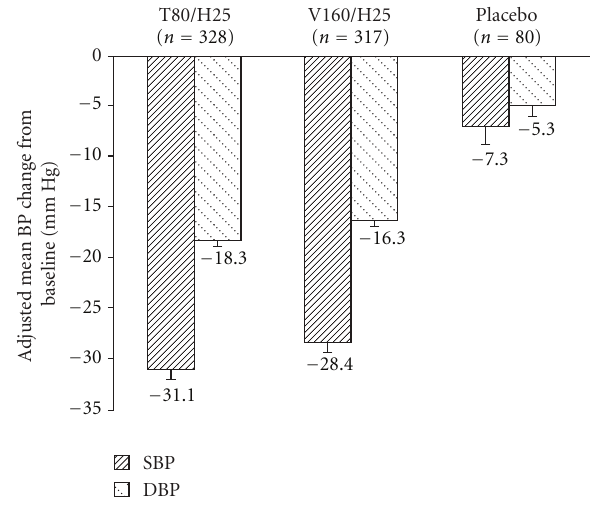
T80/H25 versus V160/H25: P = 0 . 0265 for SBP and P = 0 . 0041 for DBP. T80/H25 versus placebo: P < 0 . 001 for both SBP and DBP. Figure 1: Change from baseline in SBP and DBP by treatment group. (T80/H25, telmisartan 80 mg/hydrochlorothiazide 25mg: V160/H25, valsartan 160 mg/hydrochlorothiazide 25mg).